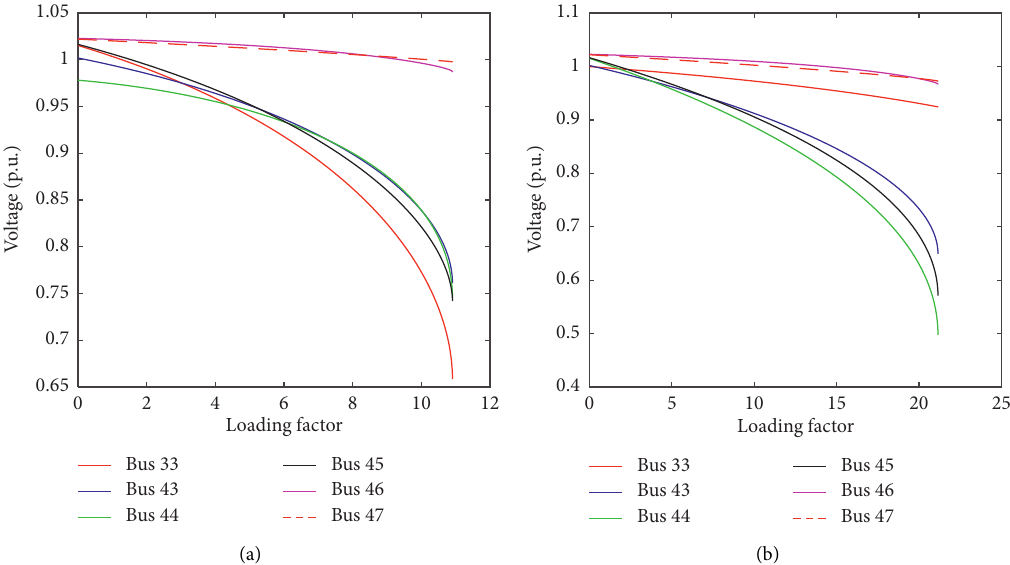
Figure 14: Voltage profile of buses during the load-increasing process when using MCPF: (a) without the integration of DGs and (b) with the integration of DGs.